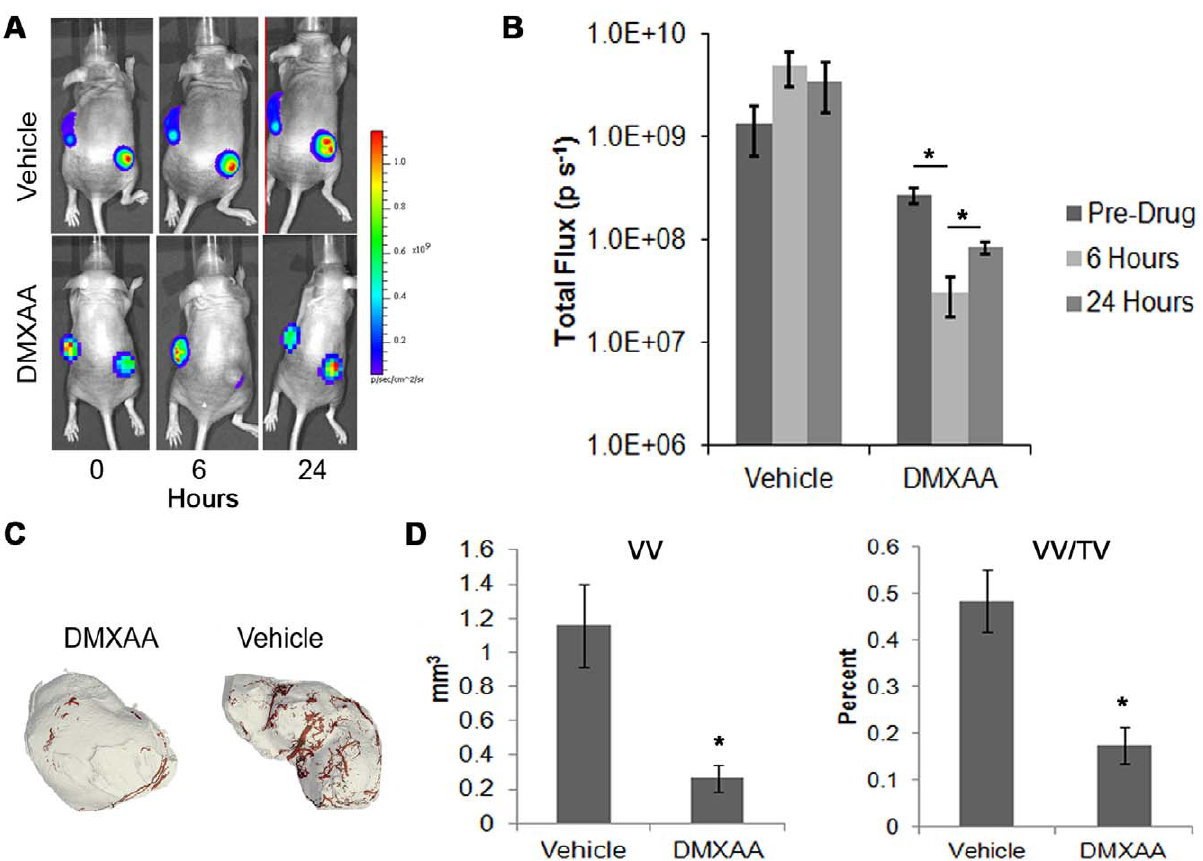
Figure 6. Validation of VDA with a human cell line. ( A ) Bioluminescence images taken just prior to DMXAA treatment, as well as at 6 and 24 hrs post treatment of NIH-III mice bearing subcutaneous tumors composed of luciferase-expressing MDA-MB-231 breast cancer cells. ( B ) Quantification of the photon flux from representative tumors demonstrates a large drop in bioluminescent signal by 6 hours. ( C ) 3-D micro-CT renderings of tumors (gray), and embedded vasculature (red), of the MDA-MB-231-Luc2 tumors. ( D ) Quantification of the binarized images demonstrating vessel volume (VV), and vessel density (VV/TV). Data represents averages 6 s.e.m. (N=3), asterisks indicate p , 0.05. Figure S1 Micro-CT imaging of tumor vasculature. X- ray micrograph (left) of a mouse bearing large metastases in the vicinity of the left pelvis (yellow box). 3-D rendering (right) of the Microfil-perfused metastasis reveals the tumor vasculature and general outline of the tumor (the left knee has been cropped out of picture). The sacrum (red asterisk) and iliac crest (yellow asterisk) are visible since Microfil has a similar contrast density to bone. Figure S2 Histology of necrotic areas in H1299 tumors. H&E stained image of a H1299 subcutaneous tumor (left) showing largely empty necrotic areas (yellow arrowheads) in close proximity to vessels (black arrows) that would be predicted to be filled by the contrast medium. Immunohistochemical stain with a CD31-specific antibody (brown stain), and counterstained with hematoxylin, demonstrating small vessels (black arrows) in the proximity of an empty necrotic area (red arrowheads). The latter serving as sites of Microfil infiltration in the H1299-derived subcutaneous tumors.